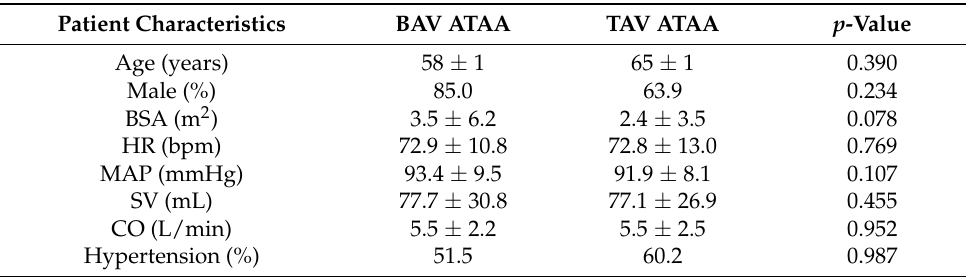
Table 1. Clinical and demographic characteristics of patient study population. Mann–Whitney test with α =